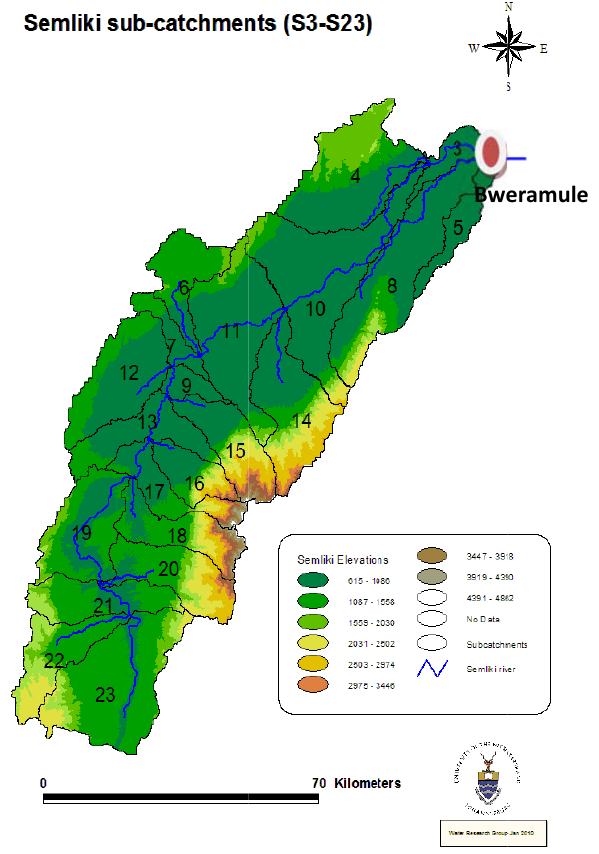
Figure 5 Projection of cases from the PCA of variables Fig. 5. Projection of cases from the PCA of